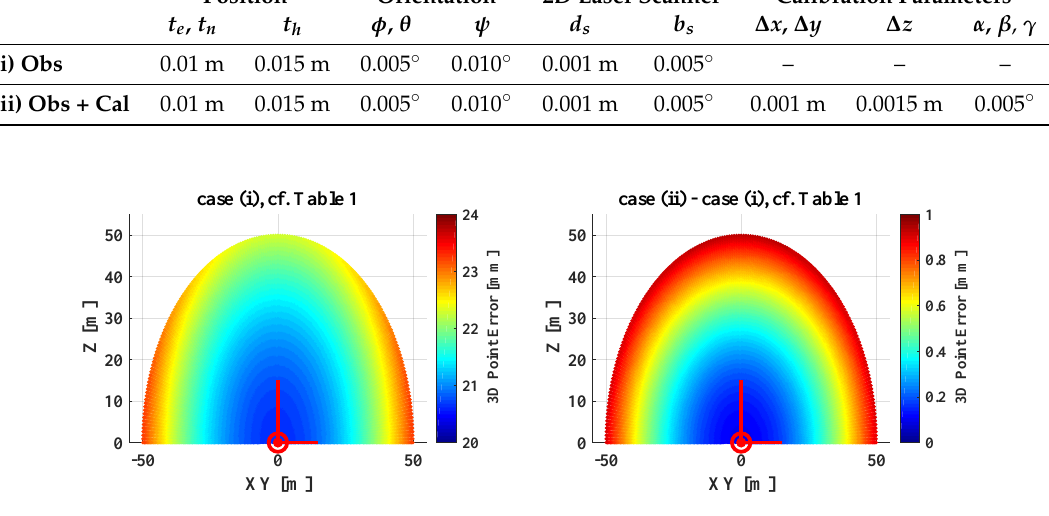
Figure 4. ( Left ) 3D point error of the mobile point cloud with observation errors only (Table 1, case (i)), ( Right ) Additional uncertainty of the point cloud due to calibration errors (Table 1, case (ii) – case